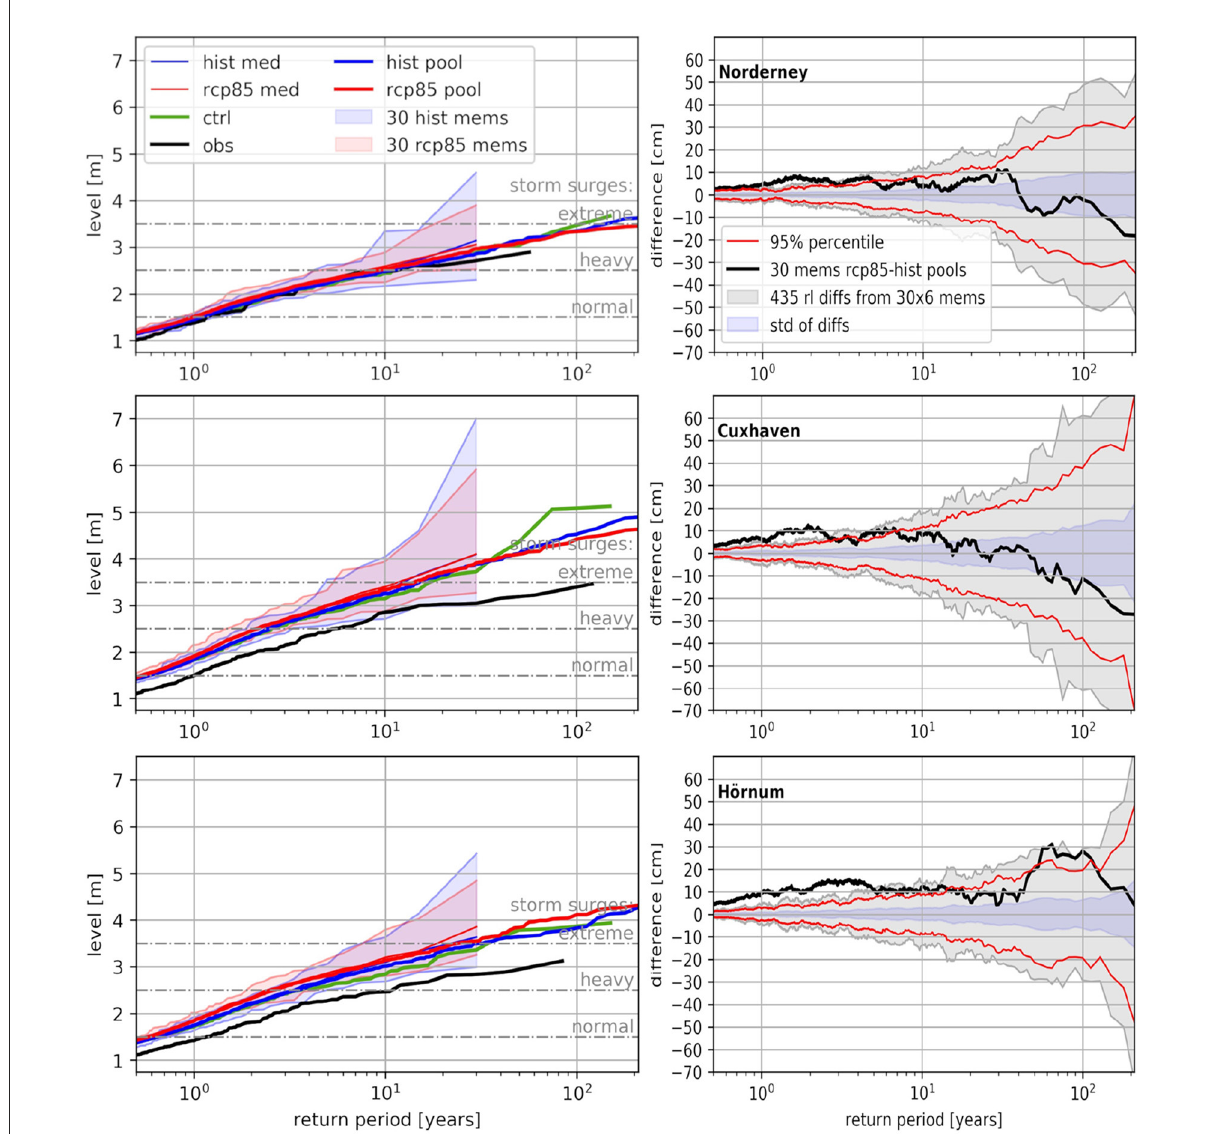
FIGURE5 (Left) Return value plots for extreme ssh above MHW (yearly 10 highest) at Norderney, Cuxhaven, and Hörnum for observational data (black), PI control simulation data (green), ranges of 30 members for hist (blue shading) and rcp85 (red shading) simulation data and for the hist (red) and rcp85 (blue) pooled data. Thin red and blue lines display the median of the corresponding range. Measured data are relative to MHW (1970–1999), PI control data to MHW (1950–2099), hist member results to MHW (1970–1999), rcp85 member results to MHW (2070–2099). (Right) Difference of pooled rcp85-hist data (black), range of all possible differences of 30 pools of 6 full random members (gray shading), mean of all differences ± std (blue shading), 95 % confidence interval of all differences